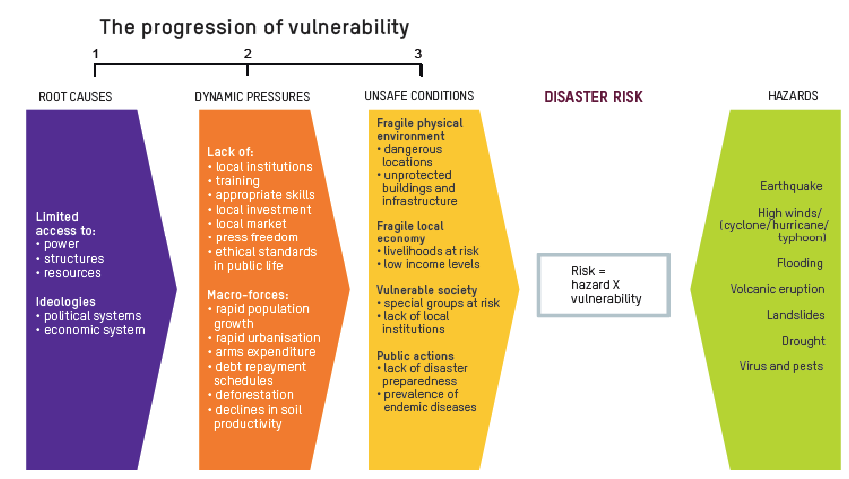
Figure 3. Original crunch model (Oxfam [53]).